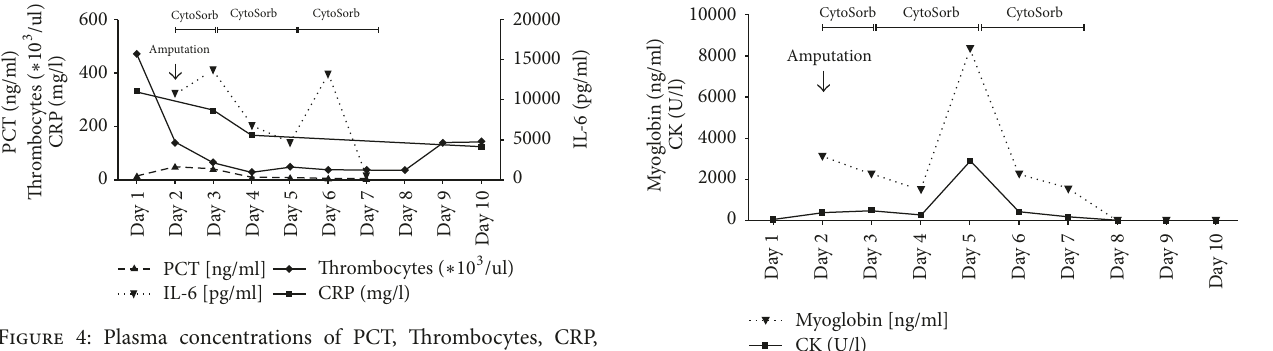
Figure 4: Plasma concentrations of PCT, Thrombocytes, CRP, and IL-6 during the course of the three Cytosorb sessions. Day 1 represents start of treatment after postoperative transfer to the ICU. Figure 5: Plasma concentrations of Myoglobin and CK during